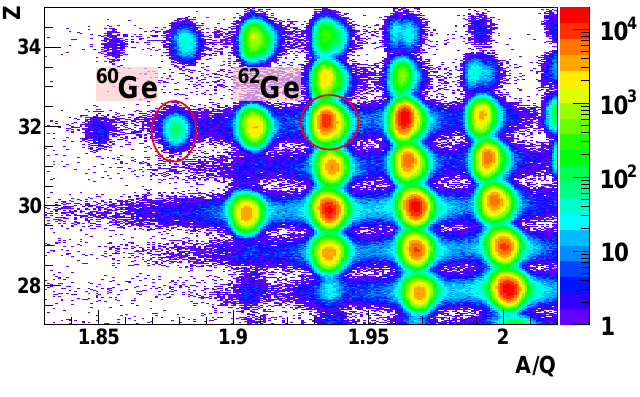
Figure 1. Identification plot for the 60 Ge and 62 Ge